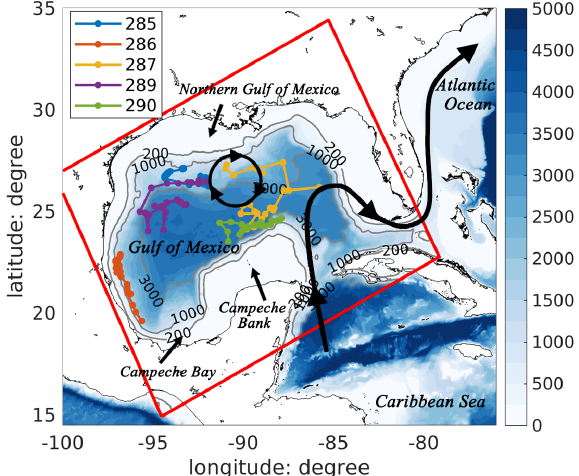
Figure 1. Bathymetric map of the Gulf of Mexico with a schematic pattern of the Loop Current (black curve with arrows) and Loop Current eddies (black circle with arrows). Trajectories of five BGC- Argo floats (colored lines) in 2015 are also shown in the figure. The model domain is represented by the red